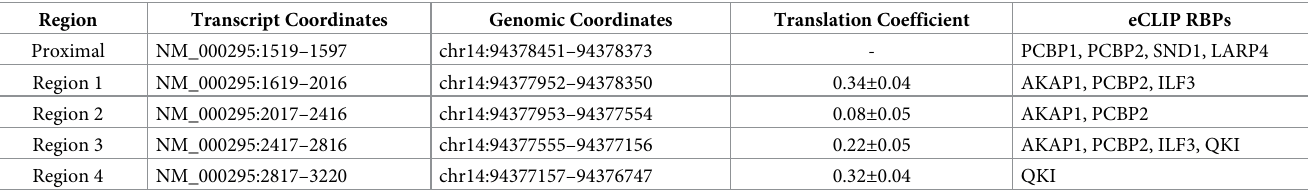
Table 1. Translation Coefficient of SERPINA1 3 0 UTR